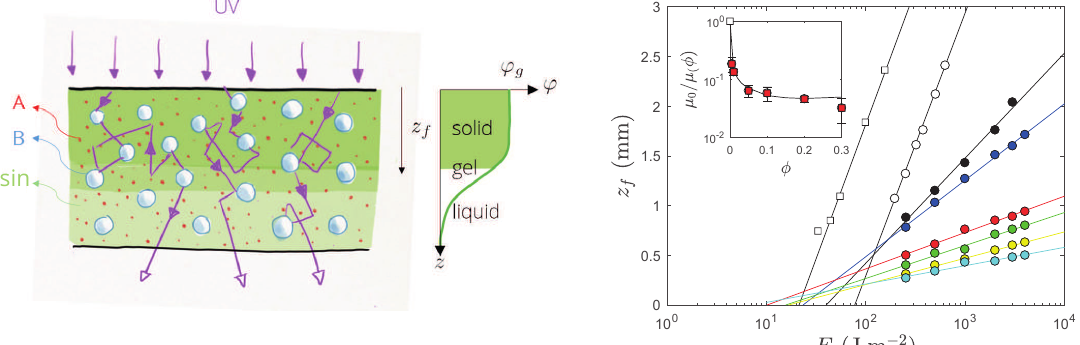
Figure 3. Left : sketch of the FPP geometry where a thick slab containing a formulation [resin + photo-initiator (A) + particle (B)] is exposed to a collimated UV-light and thickness-dependent profile of photo-conversion of the resin develops in depth (inspired by Ref. [11], where ϕ denotes the degree of monomer conversion, and ϕ g the gel point that occurs upon a given cross-link value). Right : Cured thickness z f during frontal polymerization of the PEG-DA formulations against UV dose for several cases with no calcite (open symbols, circle for no degassing, square for degassed polymer) or with di ff erent volume fractions φ of calcite but no degassing ( φ = 5 × 10 − 3 , 1 × 10 − 2 , 5 × 10 − 2 , 0.1, 0.2, 0.3, black, blue, red, green, yellow, cyan symbols respectively). Insert: slope of the front propagation curve µ ( φ ) − 1 normalized by the one of the bare resin; the line is a model not discussed here.